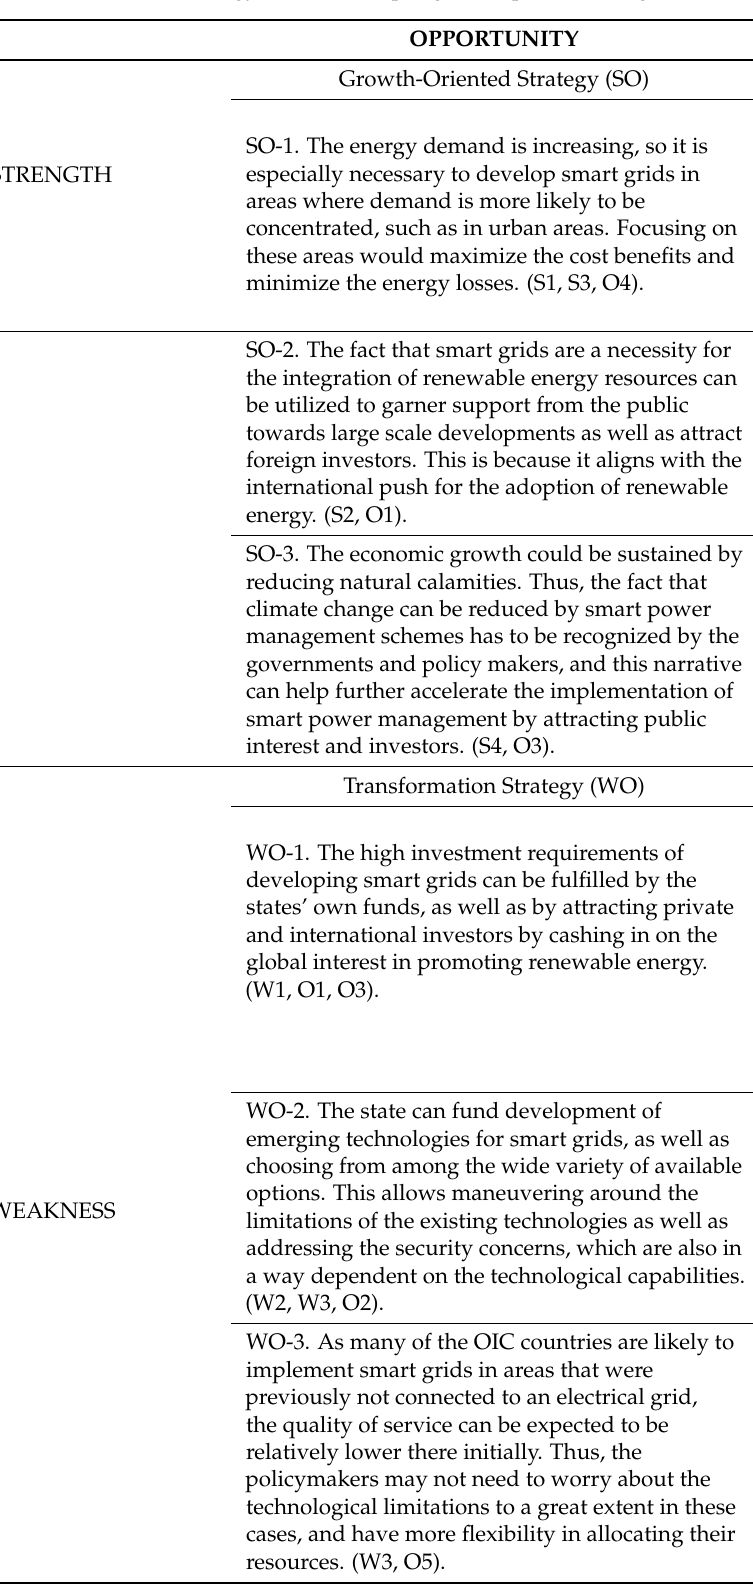
Table 13. TOWS matrix. The Growth-Oriented Strategy (SO), Diversification Strategy (ST), Transformation Strategy (WO), and Defensive Strategy (WT) for adopting smart power management in OIC